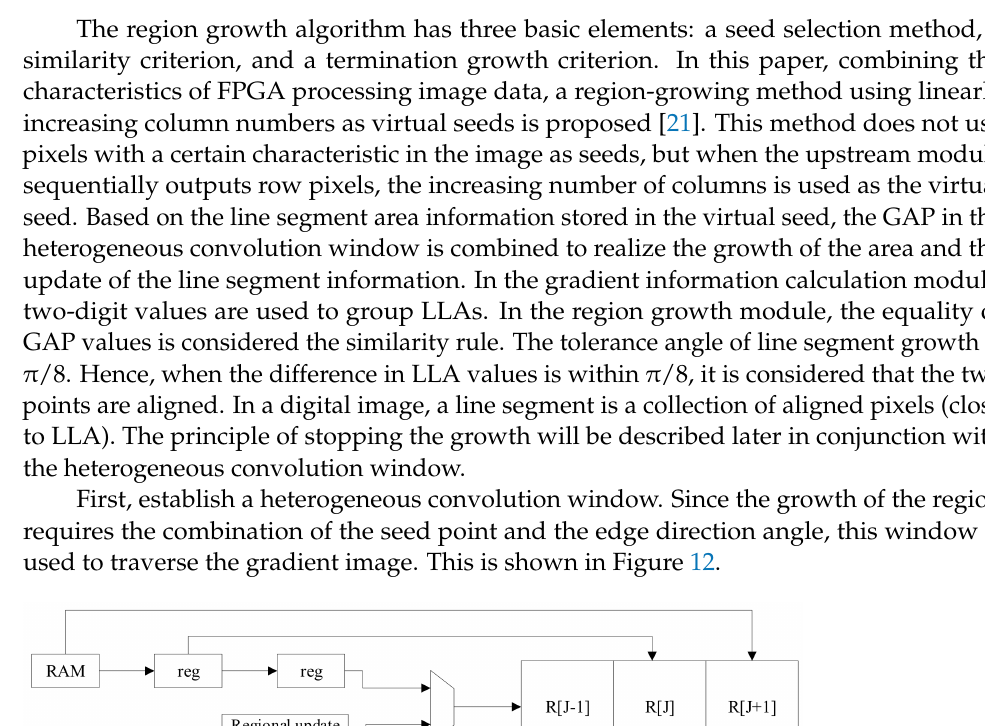
Figure 11. Processing flow of regional growth module.